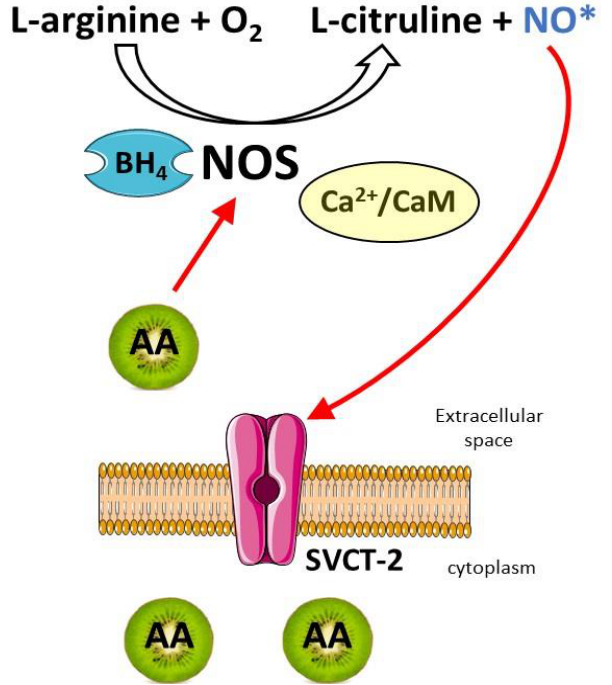
Figure 2. Vitamin C and NO signalling. Increase in Ca 2+ leads to the formation of Ca 2+ /CaM complex, which binds NOS and stimulates NO production from L-arginine. NO increases the expression of sodium-dependent vitamin C transporter (SVCT-2) allowing for vitamin C intracellular accumulation. Ascorbate also affects regeneration of tetrahydrobiopterin (BH 4 ) positively modulating NO generation. NO